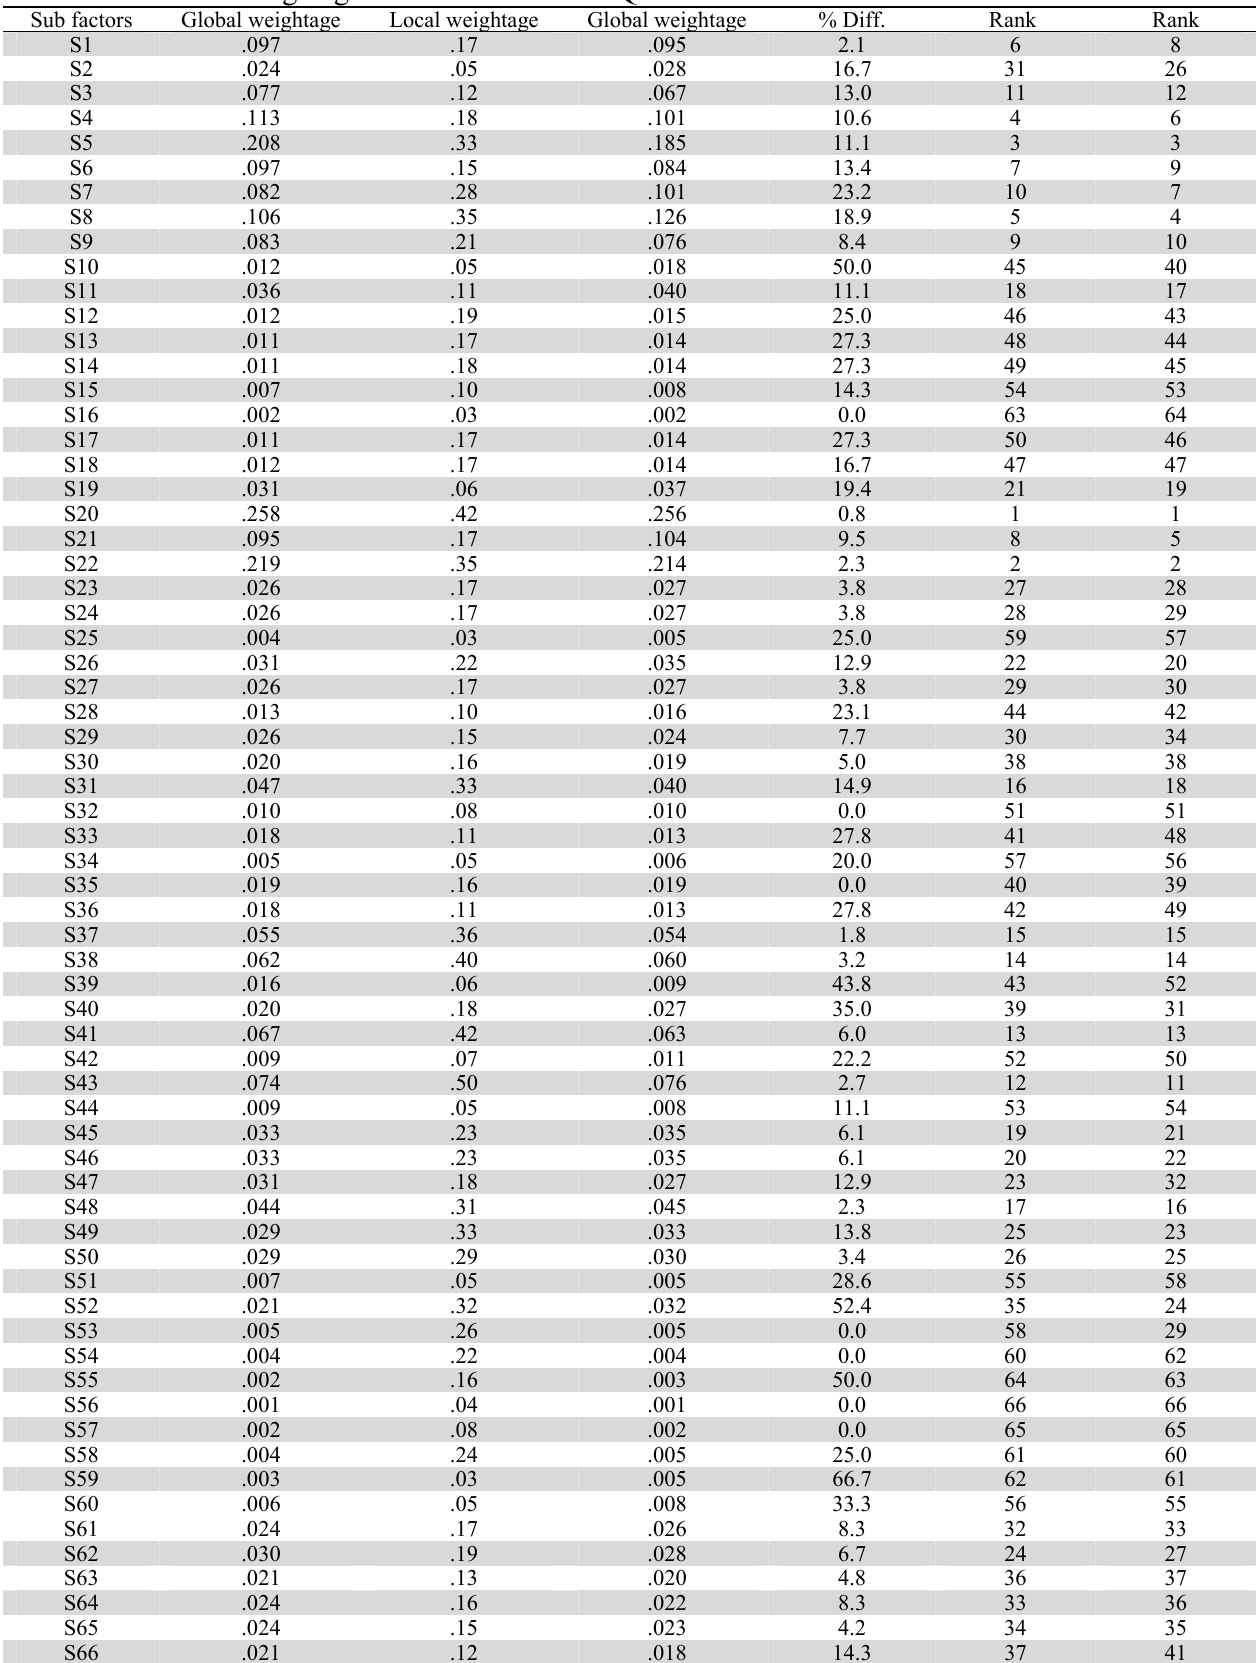
Local and Global Weightages of Subfactors of MQFD model Sub